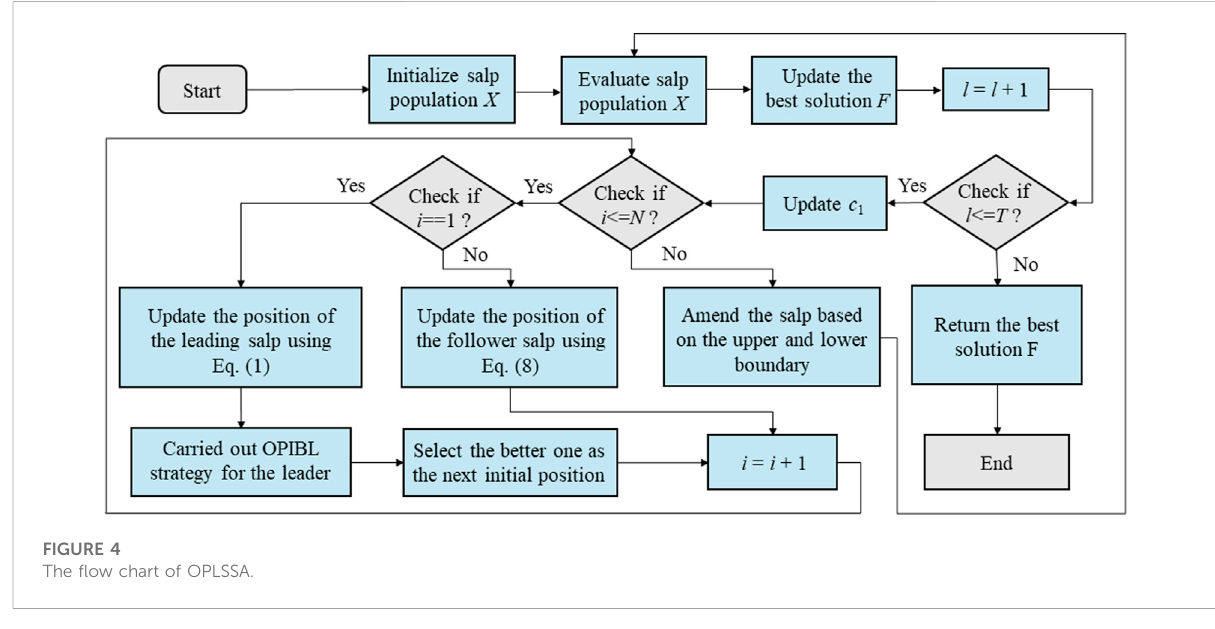
TABLE 2 The characteristics of the classical benchmark functions. Function type Function formulation Search range f min